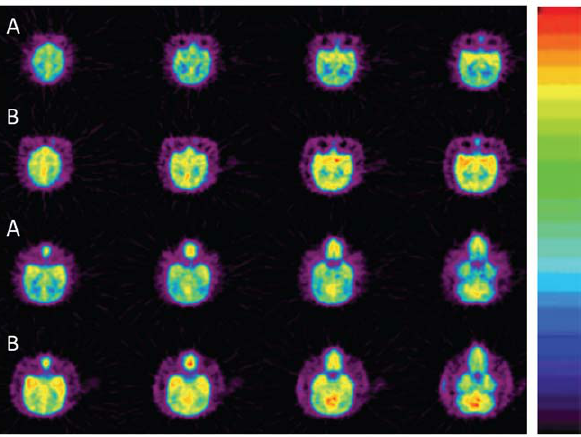
Figure 3. Summed images of tracers 1 (A) and 2 (B) in the brain of Pearl (from 0 to 10 min), alcohol distributed in all brain regions. Tracer 1 showed higher uptake in striatum and cerebellum; and tracer 2 in striatum, thalamus, cerebellum, and cingulate. Tracer 2 had consistently higher uptake than 1 across all brain regions.